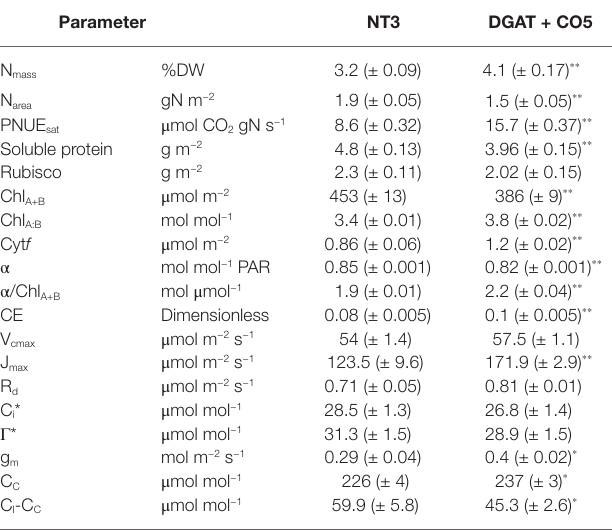
TABLE 3 | Biochemical and gas exchange parameters for Lolium perenne DGAT + CO5 and NT control 3 weeks after defoliation. Parameter